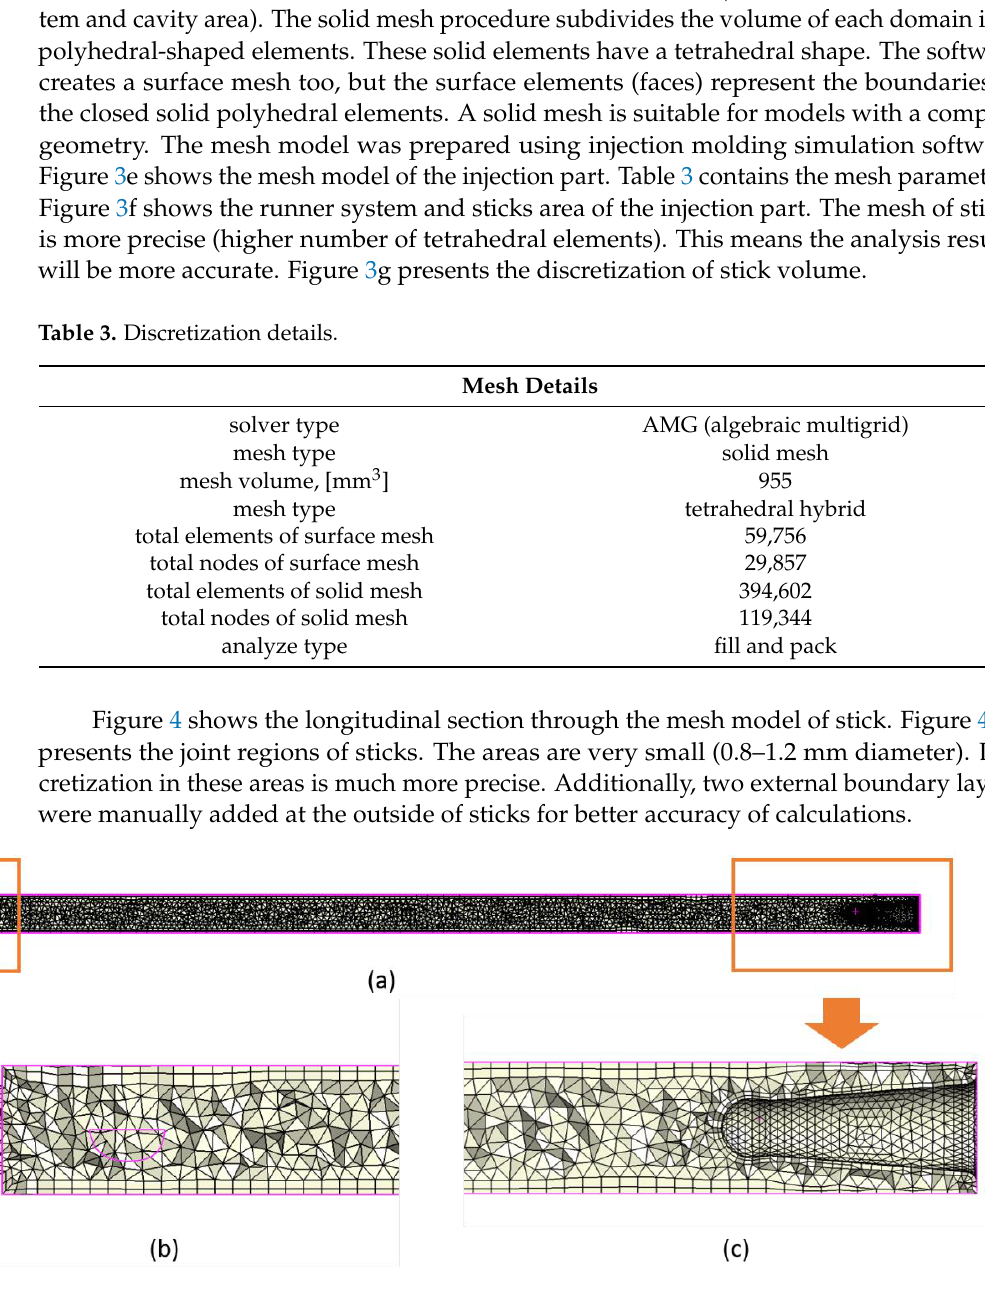
Figure 4. Three-dimensional (3D) mesh model of stick: ( a ) clipping section; ( b ) external joint region (boundary layers are visible); and ( c ) internal joint region (boundary layers are visible).